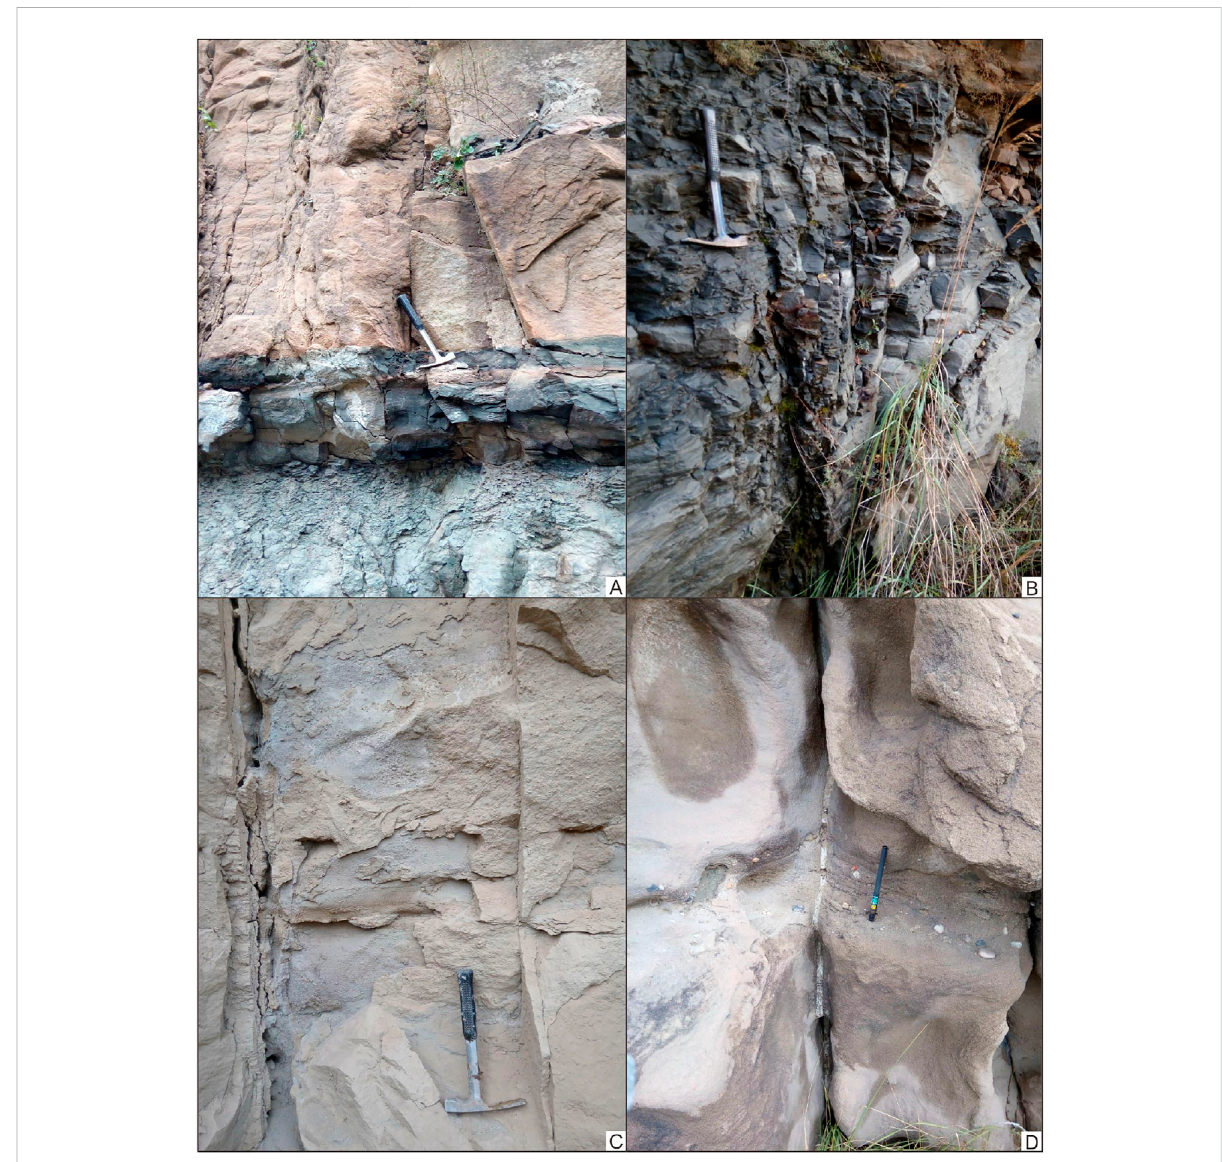
FIGURE 2 Structural fractures in the Yanchang Formation: photographs from the fi eld. (A) Structural fractures are developed in sand – mud interbeds at Jiaxian, but fractures are basically not developed in the in the lower mudstone. (B) The shear fractures developed in mudstone at Suide have a small spacing and short extension distance. (C) The shear fractures developed in the sandstone at Xunyi have a large spacing and long extension distance. (D) ThisshearfracturedevelopedinthedensesandstoneatDingbianis fi lledwithcalciteandhasawidthof2.0